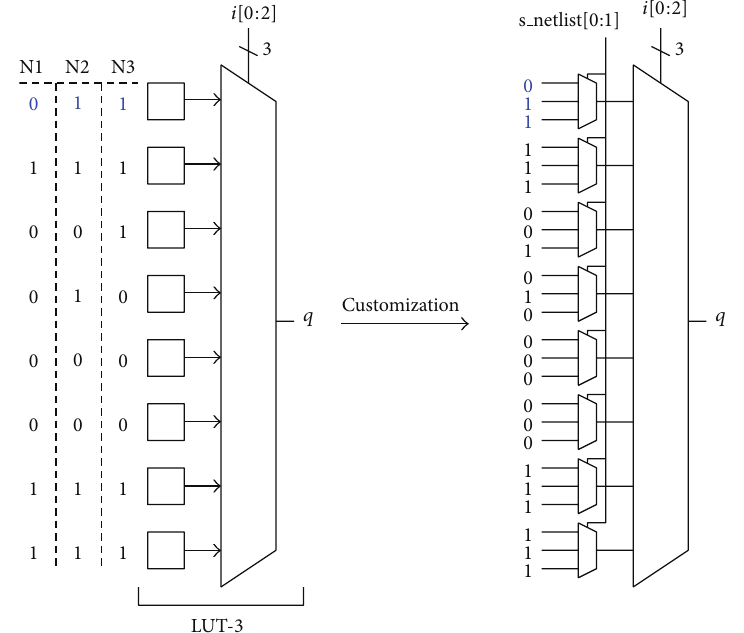
Figure 10: Customization for 3 netlists (N1, N2, and